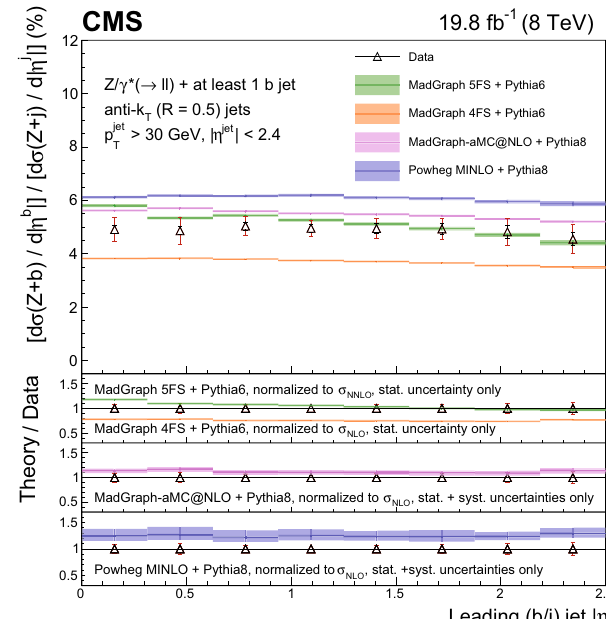
, stat. + syst. uncertainties only NLO σ MadGraph-aMC@NLO + Pythia8, normalized to